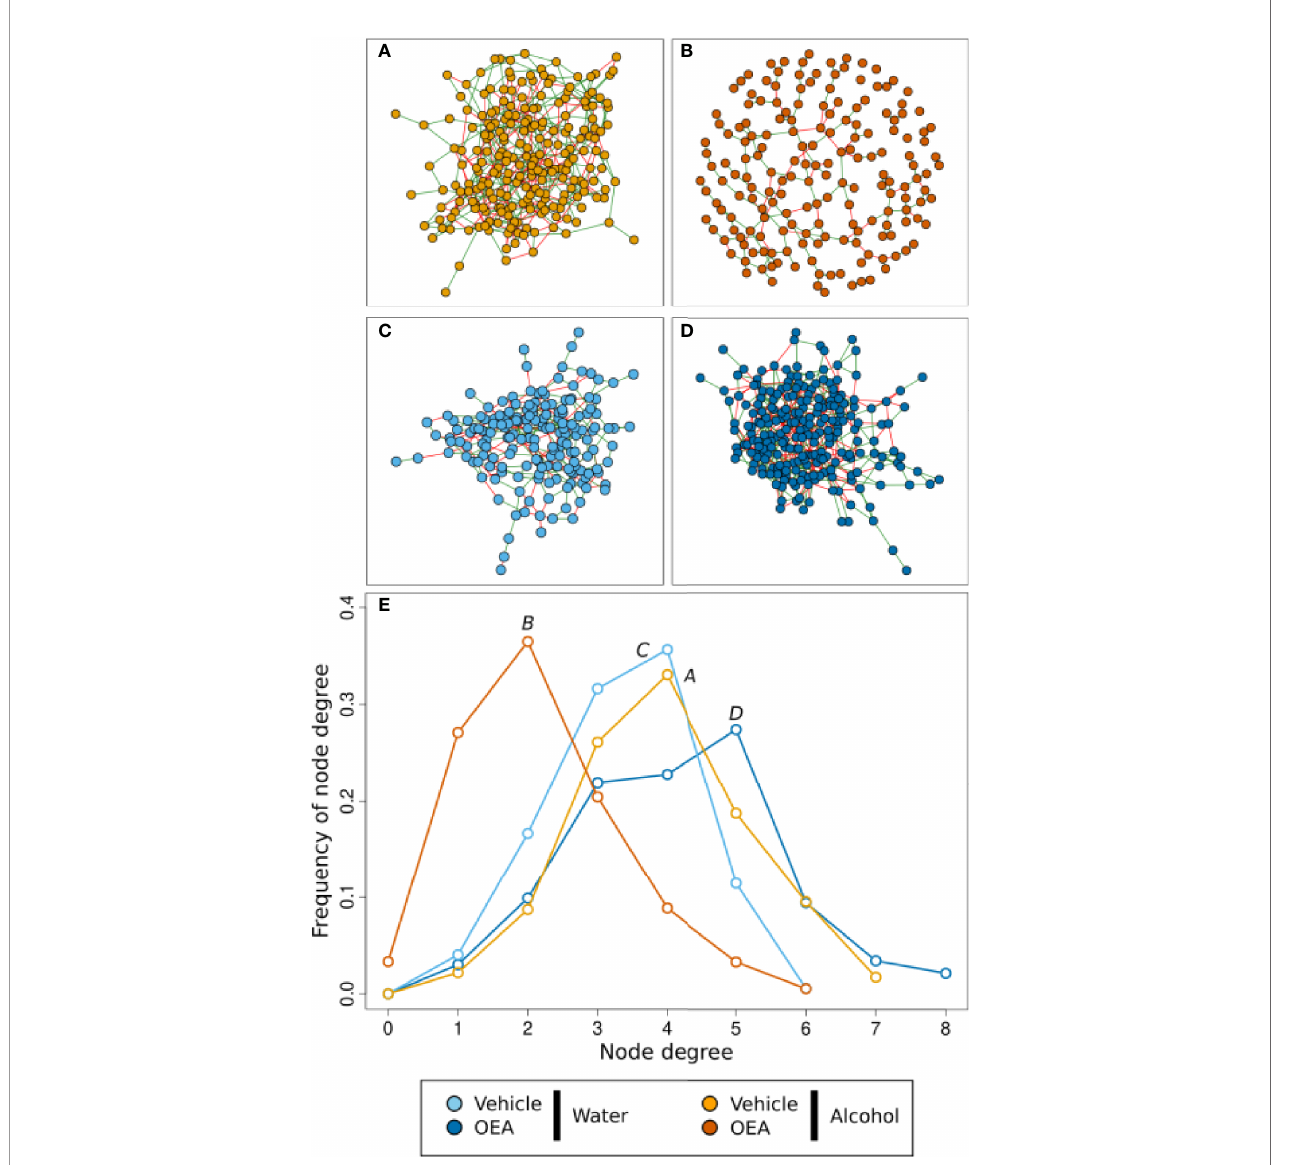
FIGURE 4 | Microbiota association network on the T1 sample subset. (A – D) Graphic representation of inferred networks for each group, as indicated by the color of nodes. The graphical representation of the association network is composed of nodes (i.e., circles) connected by edges (i.e., the segments between nodes). Each node represents an ASV of the community, while each edge represents the presence of a signi fi cant association between two ASVs. There is a positive association when edges are green, while there is a negative association when edges are red. (E) Frequency distribution of the node degree statistic of the four inferred networks. In this representation, we report the frequencies (i.e., % of total) of nodes in the network for each value of node degree (i.e., a statistic representing the number of nodes connected to each node). Each network is represented as a different line, color coded as reported in the legend. Water + vehicle group, n = 6; water + OEA group, n = 11; alcohol + vehicle group, n = 8; alcohol + OEA group, n =